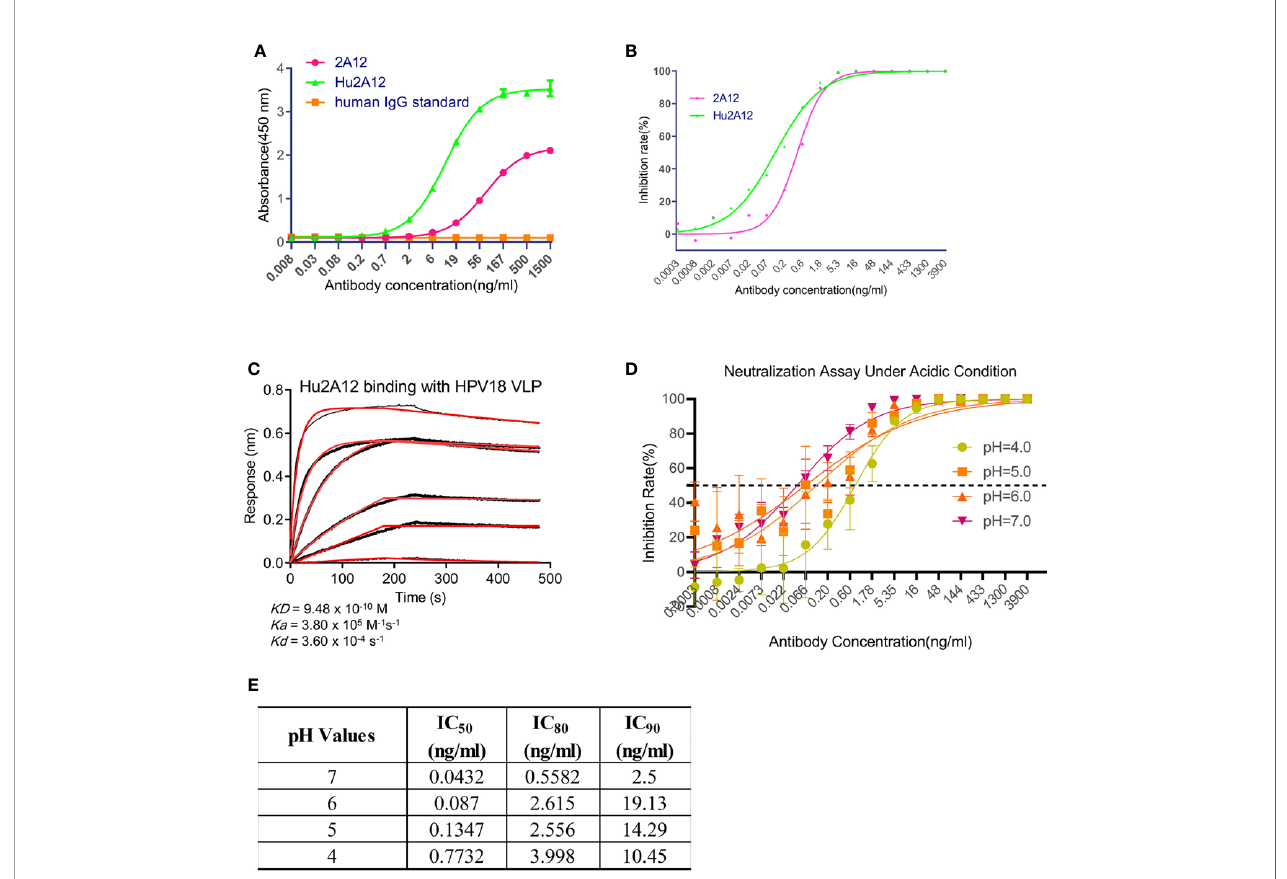
FIGURE 5 | Characterization of humanized 2A12. (A) ELISA analysis of the reactivity of 2A12 and humanized 2A12 (Hu2A12) with HPV18 VLP. PBS binding with sGn served as a control (Blank). Data represent mean ± SEM (B) Neutralization activity of Hu2A12 against HPV18 pseudovirus infection. Data represent mean ± SEM. (C) Kinetic binding curve of Hu2A12 with HPV18 VLP. Binding curves are colored black, and fi t of the data to a 1:1 binding model is colored red. (D) Neutralization activity of Hu2A12 against HPV18 pseudovirus infection under various pH. Different color curves represent different pH. (E) The summary of the neutralization titers (IC 50 , IC 80 and IC 90 ) against HPV18 pseudovirus infection in (D) . Data represent mean ± SEM. All experiments were repeated